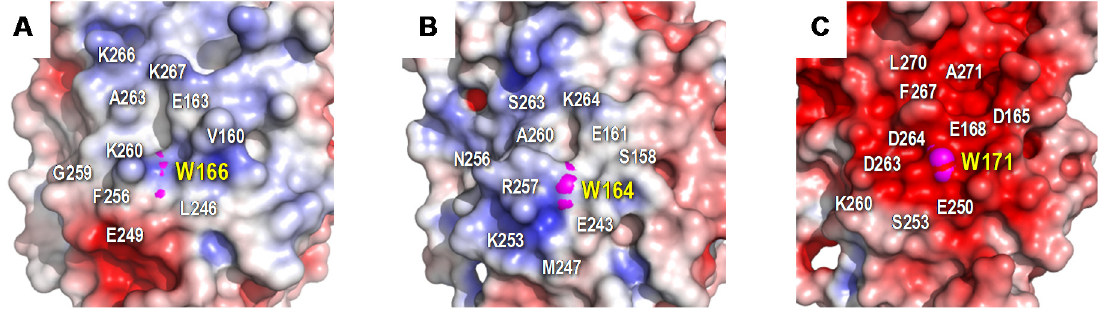
Figure 3. Electrostatic surface of the catalytic tryptophan environment in ApeLiP ( A ), P. eryngii VPL ( B ), and P. chrysosporium LiPA ( C ) calculated using the APBS-PDB2PQR software suite [56] with protonation states at pH 7.0 assigned by PROPKA [57]. Shown is the positioning of catalytic tryptophan (pink spheres) and close acidic and basic residues (together with other surrounding amino acids). Negative (red) and positive (blue) charges are indicated. PDB entries 7OO5 ( A ), 2BOQ ( B ), and 1B82 ( C ).